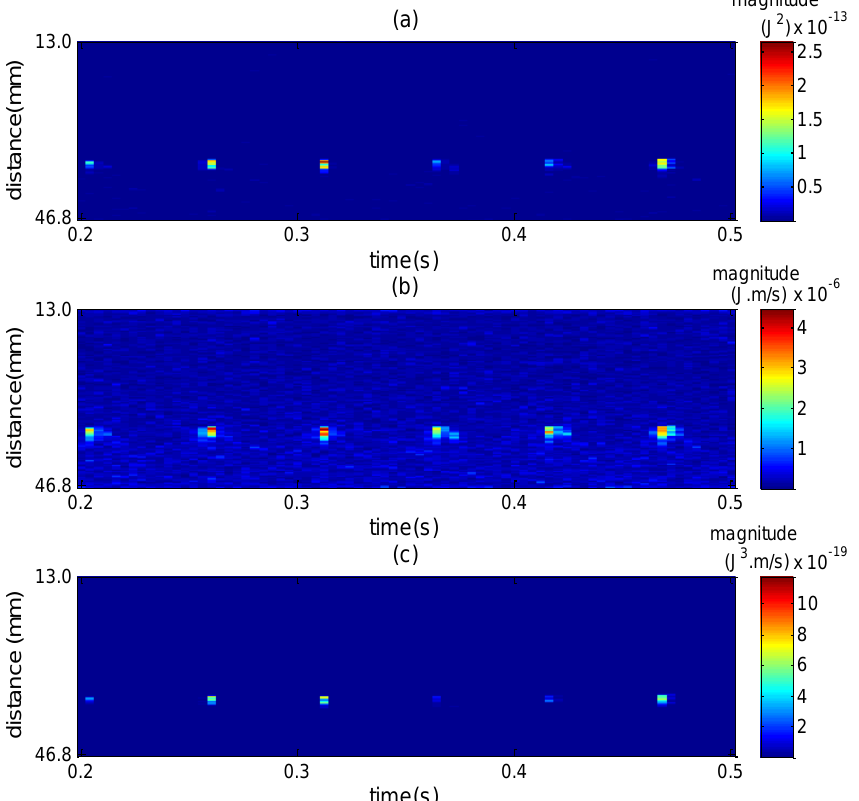
) mapping. ( c ) Point-wise 0 0